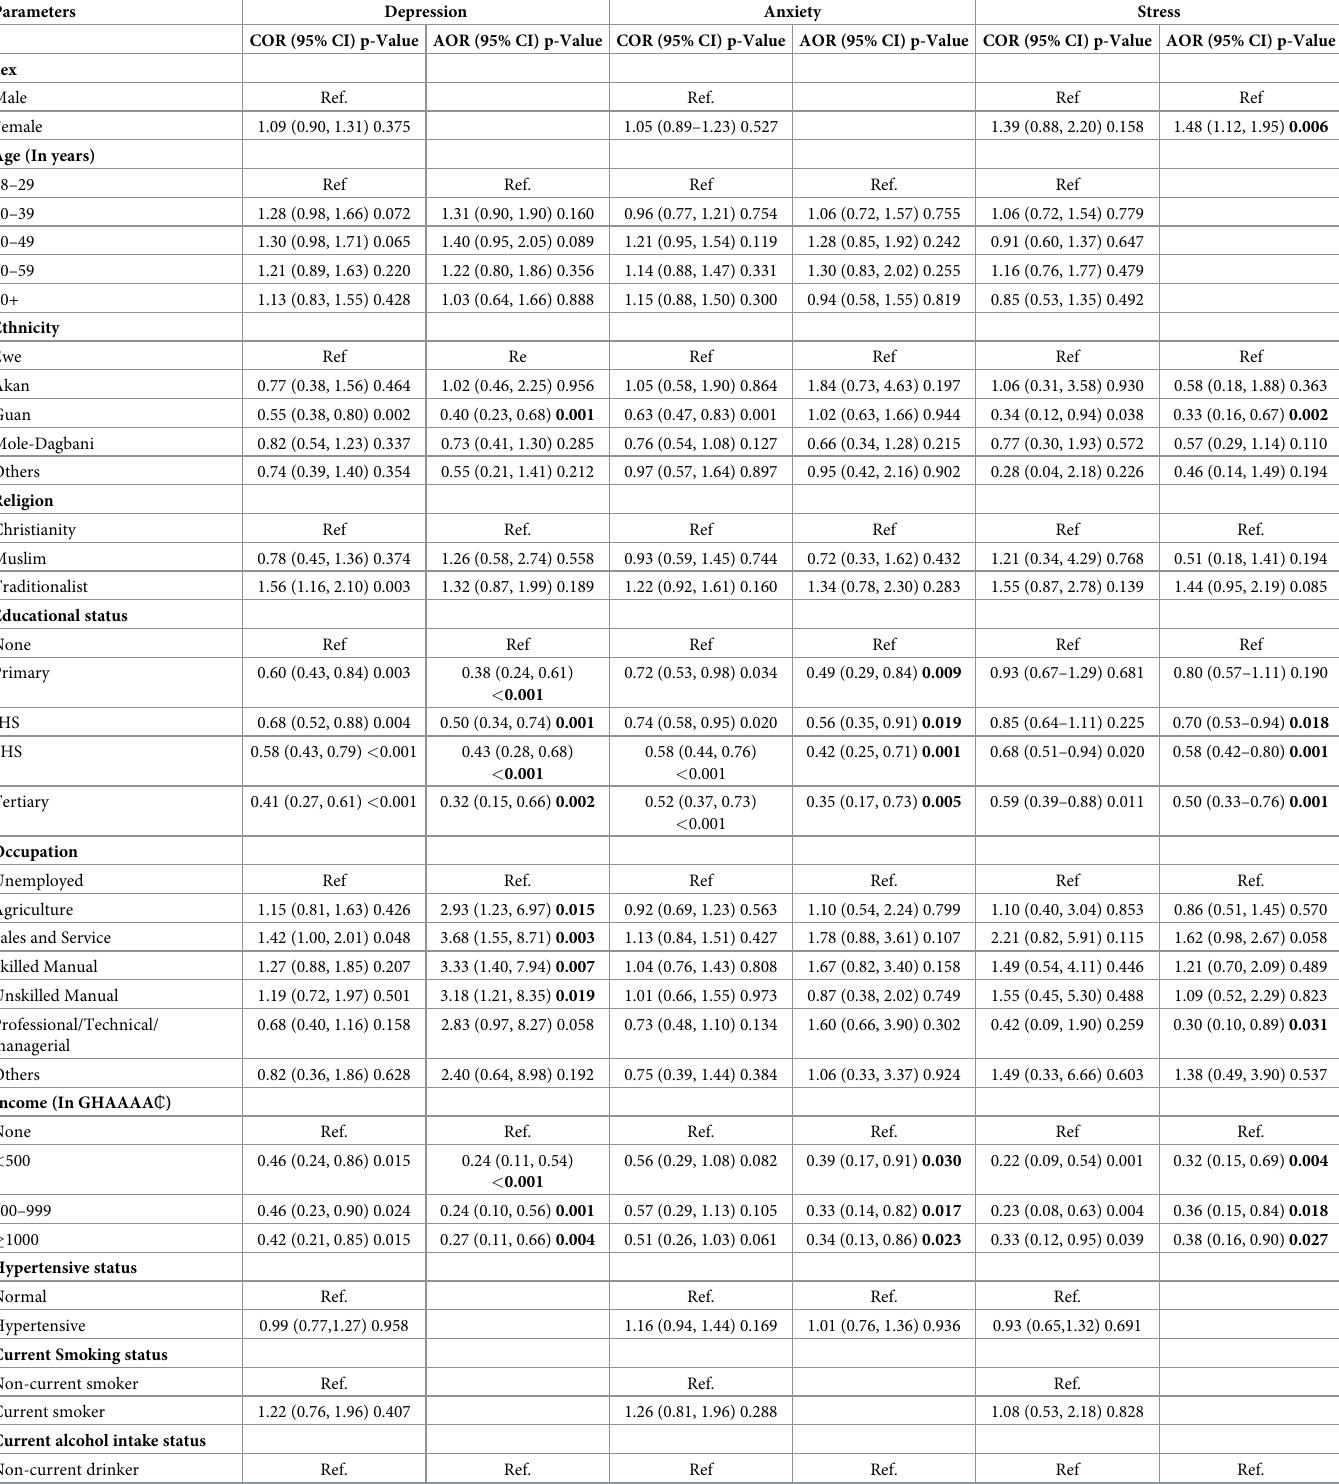
Table 3. Predictors of depression, anxiety and stress. Parameters